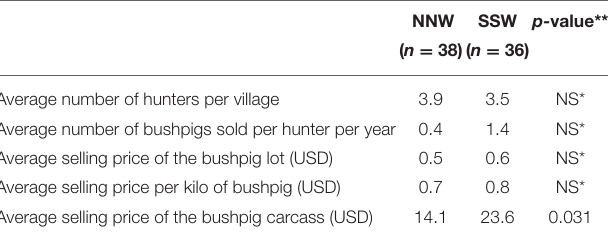
FIGURE 2 | Traditional wooden hand-made traps (Kotona), 2015 (Source: Rianja Rakotoarivony).